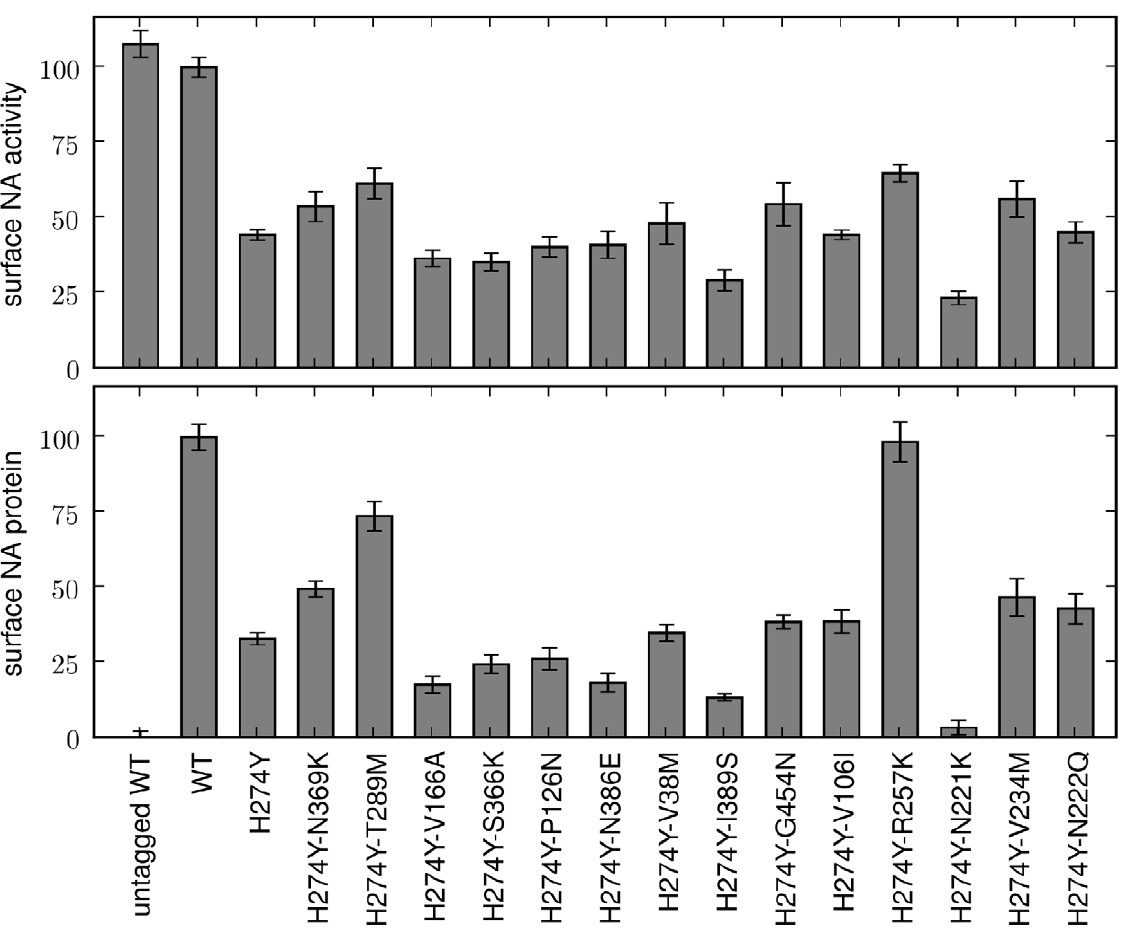
Figure 3. Several of the predicted secondary mutations partially counteract the decrease that H274Y causes in total surface- expressed activity and protein for the pandemic H1N1 neuraminidase. Shown are wildtype (WT) and indicated mutants of the A/California/ 4/2009 neuraminidase. All neuraminidases contain C-terminal epitope tags, except for the untagged WT. For the measurements, 293T cells were transfected with plasmids encoding the neuraminidase proteins. After 20 hours, the cells were assayed for the total surface-expressed neuraminidase activity (top panel) or protein using an antibody against the epitope tag (bottom panel). Bars show the mean and standard error for at least six replicates.